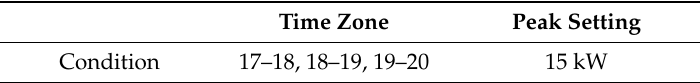
Table 7. Peak control operating